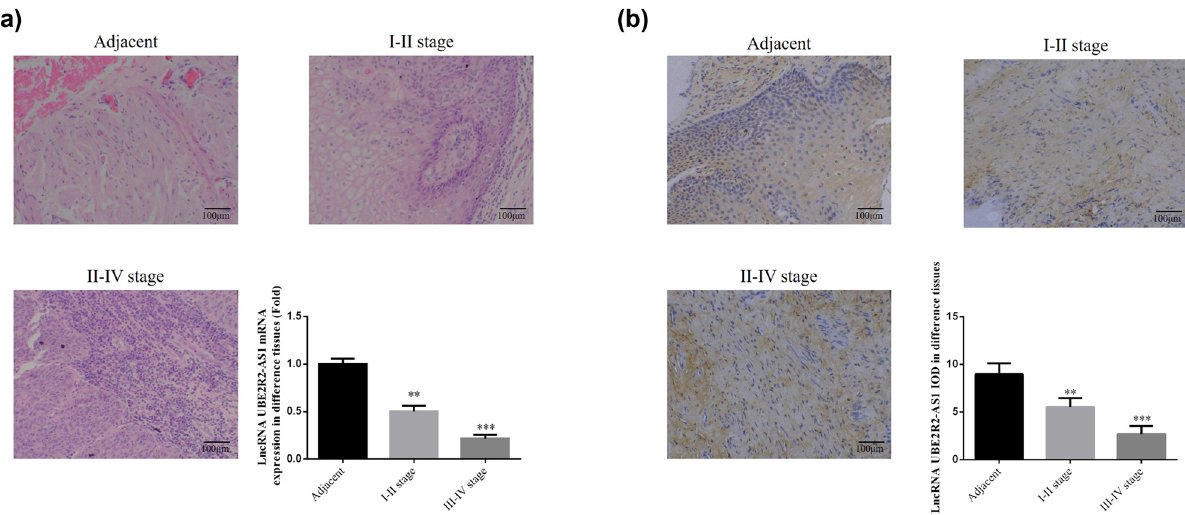
Figure 1: Clinical pathology and lncRNA UBE2R2 - AS1 expression. Adjacent: adjacent normal tissues; I – II stage: I – II stage cervical cancer tissues; III – IV stage: III – IV stage cervical cancer tissues. ( a ) Clinical pathology by HE staining ( 200 ×) and lncRNA UBE2R2 - AS1 mRNA expression. ** P < 0.01 and *** P < 0.001, compared with NC group. ( b ) lncRNA UBE2R2 - AS1 expression by ISH assay ( 200 ×) ** P < 0.01, *** P < 0.001, compared with NC group.